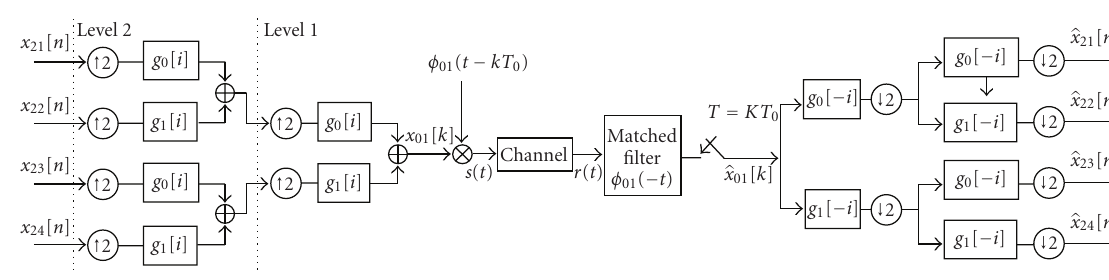
Figure 2: Transmitter and receiver for two-level WPDM system.